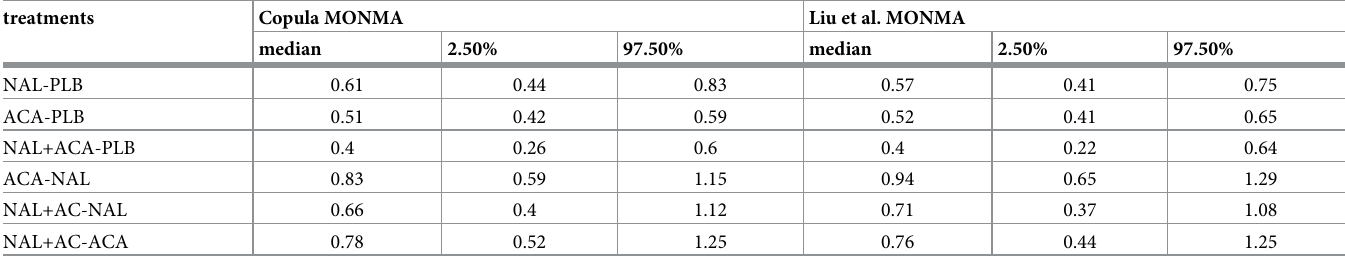
Table 6. Return to drinking: Pooled effects posterior median and HPD 95% credibility intervals. treatments Copula MONMA